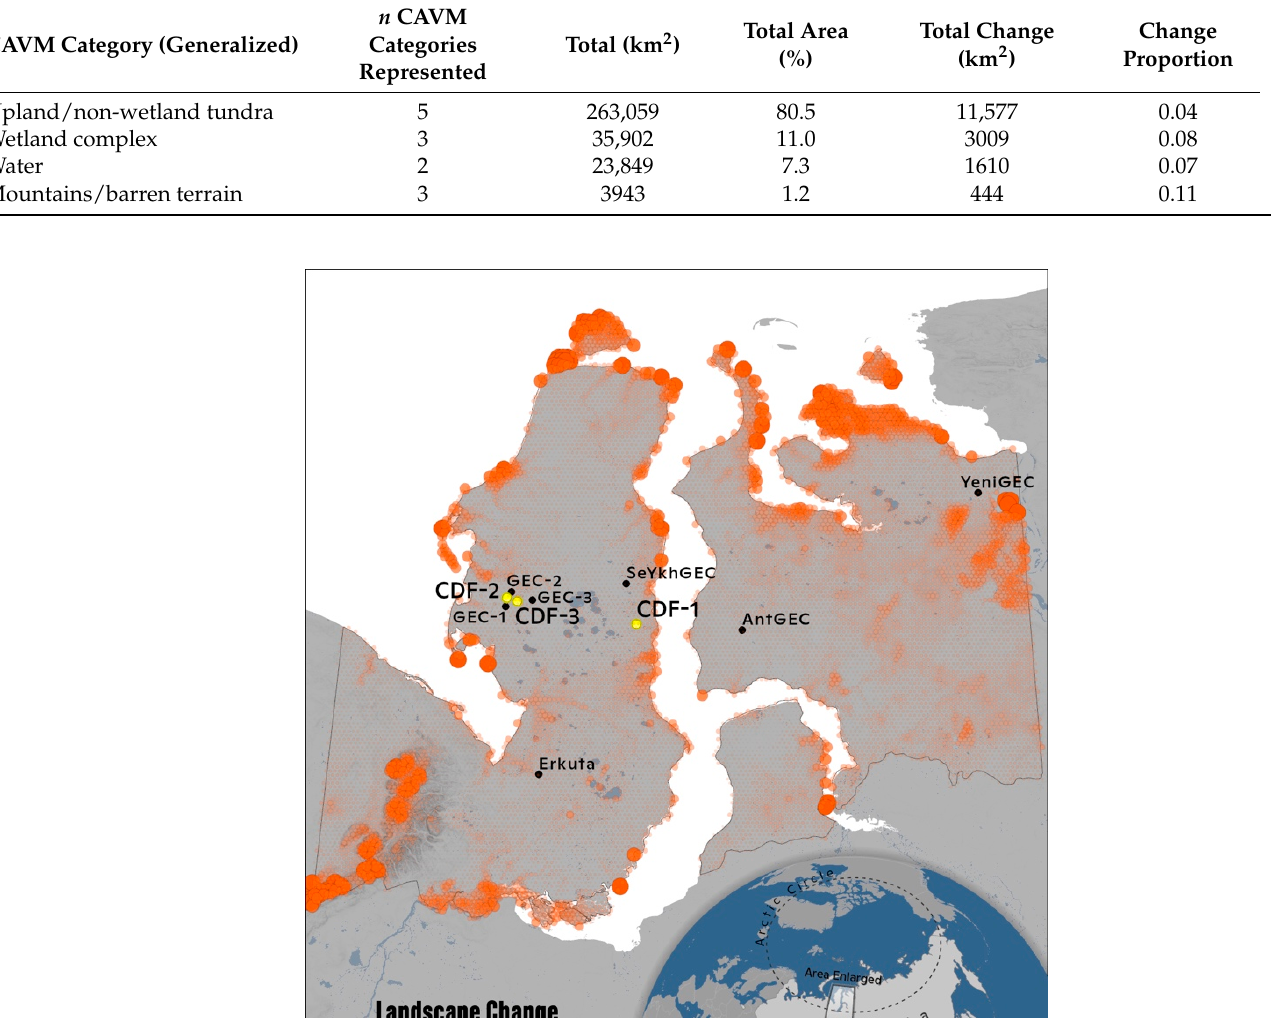
Table 1. Total area and change among vegetation and land cover categories defined by the circumpolar arctic vegetation map (CAVM) [27]. The list of detailed CAVM categories comprising each generalized category can be found in Table A2. Non-Arctic regions outside of the CAVM map (not reported) accounted for 188 km 2 (0.1%) of the study area.